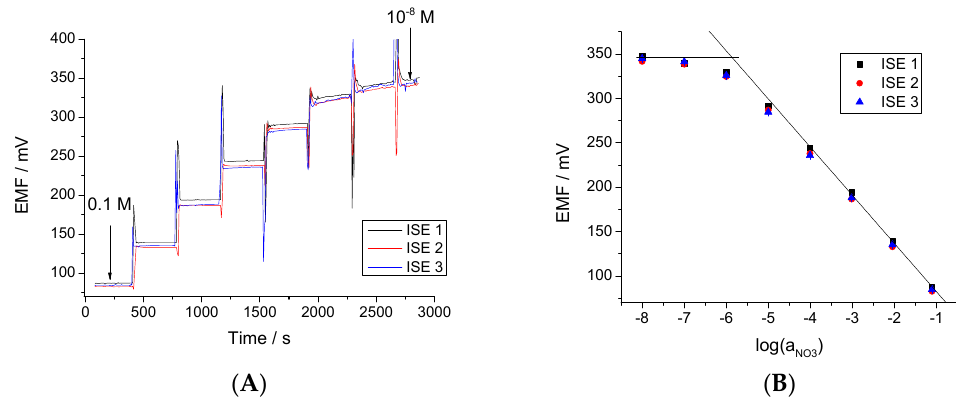
Figure 1. ( A ) Ion-selective electrode (ISE) response curves over the sequential 10-fold dilution of 0.1 M KNO 3 with deionized (DI) water; ( B ) the respective calibration curve. The straight lines in ( B ) refer to ISE 1.